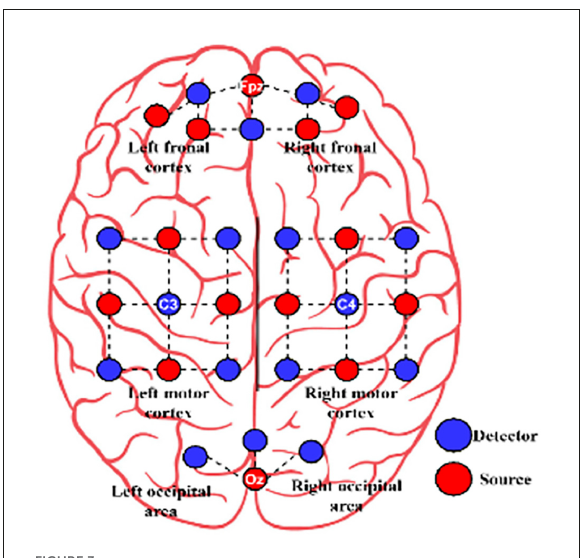
FIGURE3 The arrangement of source (red circle) and detector (blue circle) for Dataset B.